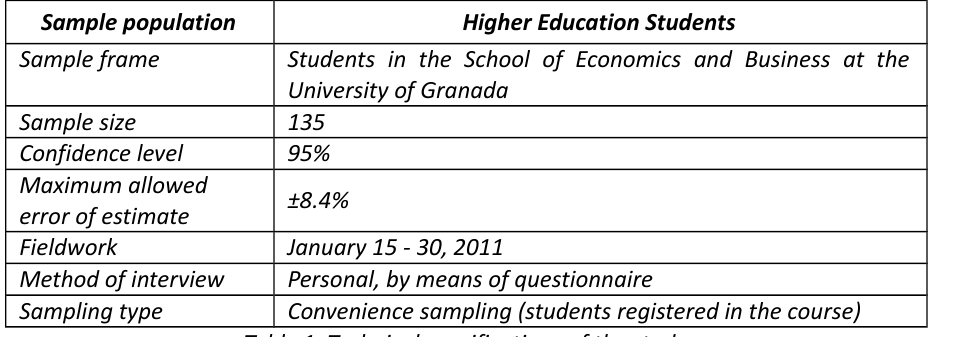
Table 1. Technical specifications of the